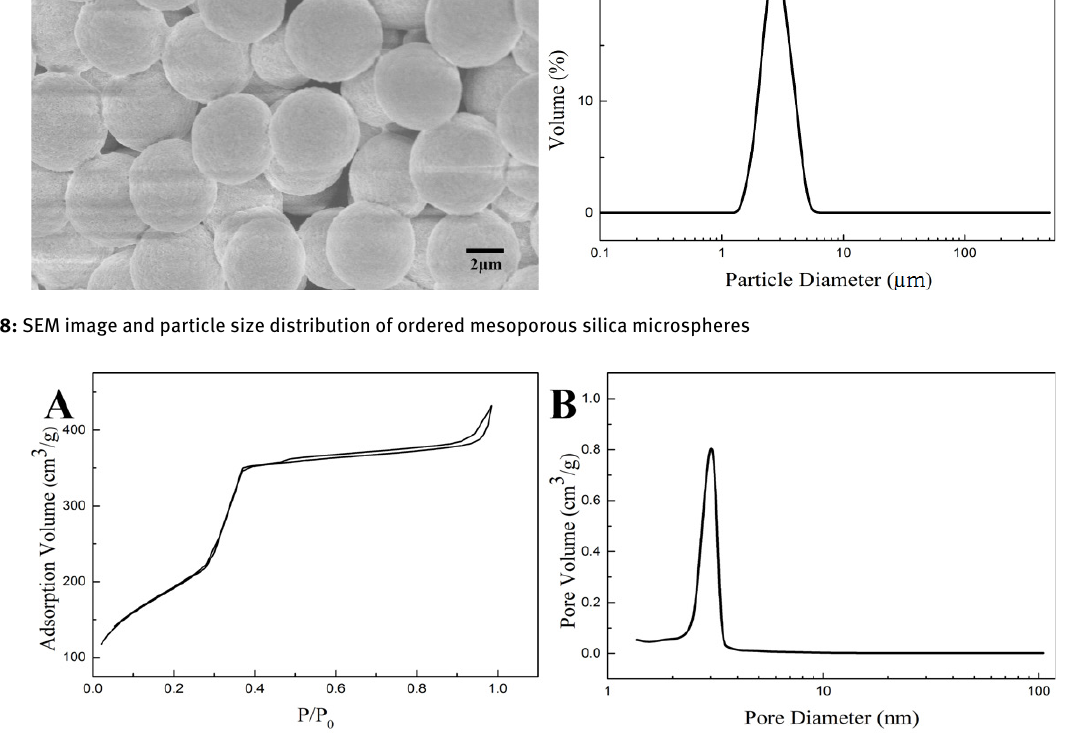
Figure 9: Nitrogen adsorption isotherm and pore size distribution of MCM-41 silica